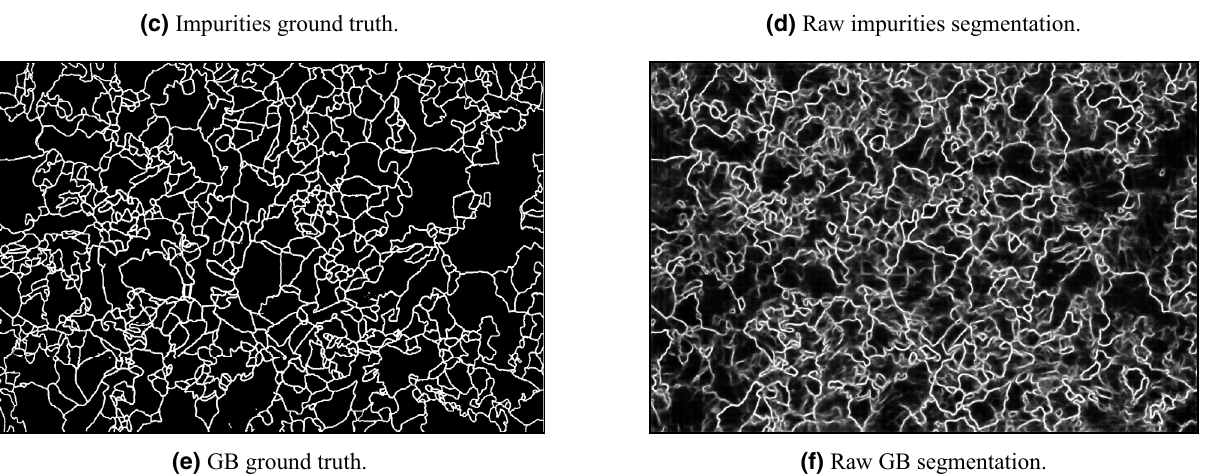
Figure 11. Segmentation pipeline applied on a test